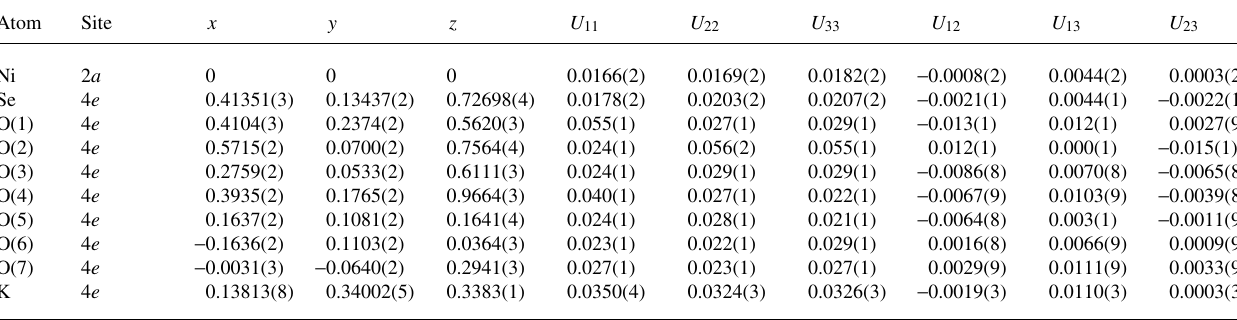
Table 9. Atomic coordinates and displacement parameters (in Å 2 ) .